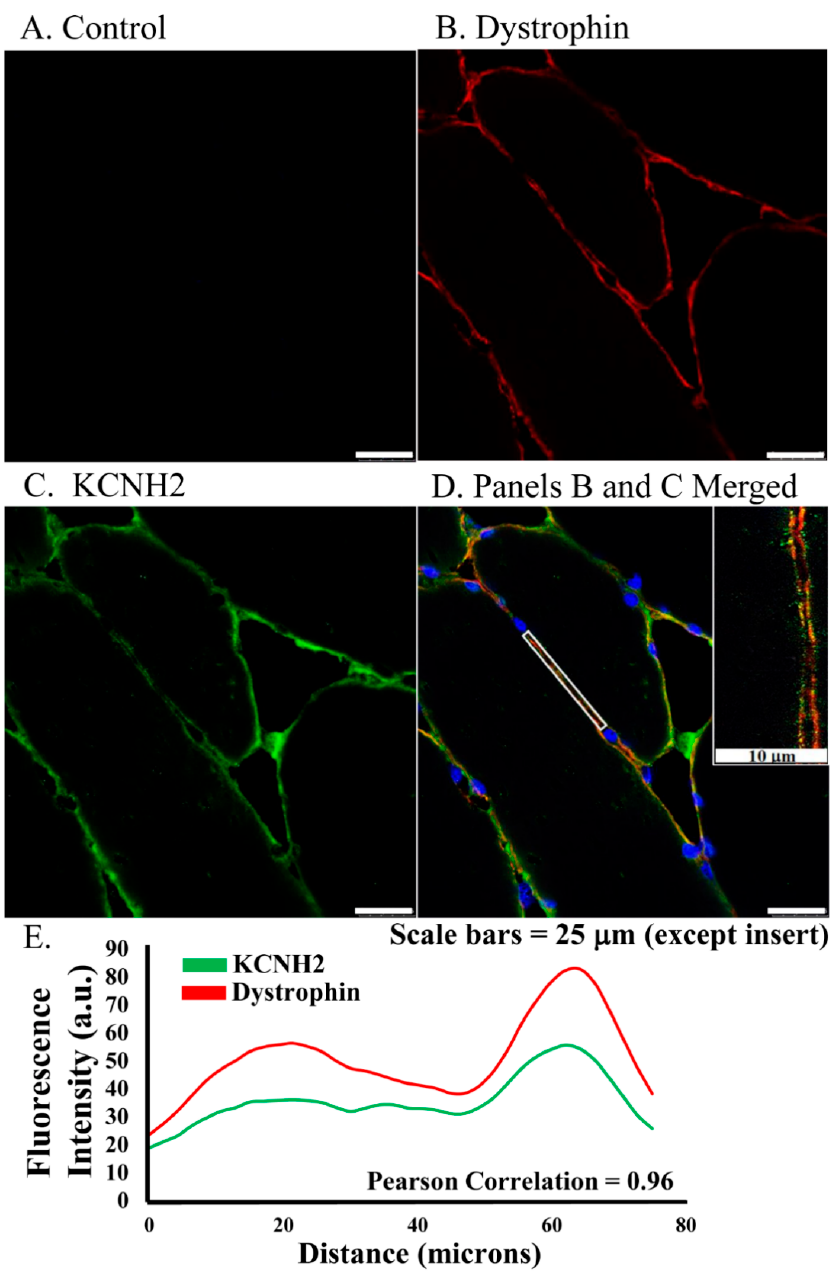
Figure 1. ERG1 fluorescence localizes to sarcolemma of human Rectus abdominis myofibers as shown by fluorescent immunohistochemistry of muscle from older healthy adults. ( A ) Fluorescence was absent from control sections immuno-stained without primary antibody. ( B ) Fluorescence (red) of dystrophin, a skeletal muscle sarcolemma marker, was detected in sarcolemma as expected. ( C ) ERG1 fluorescence (green) was detected in sarcolemma. ( D ) ERG1 (green) and dystrophin (red) immunofluorescence were both detected in the sarcolemma of human Rectus abdominis muscle. The white rectangular region is the area in which the fluorescence intensity ( E ) was measured. The inset image is taken from within the white rectangle. DAPI staining (blue) revealed nuclei. Scale bar is 25 µ m except for inset where scale bar is 10 µ m. Samples were stained and imaged using the same parameters in a single setting. ( E ) ERG1 (green) and dystrophin (red) fluorescences both localize to the sarcolemma as evidenced by fluorescence intensities, which follow the same pattern through the demarcated (white rectangle) region of the sarcolemma of this representative section. Images were acquired using a Leica DM4500 microscope with a Leica DFC 340FX